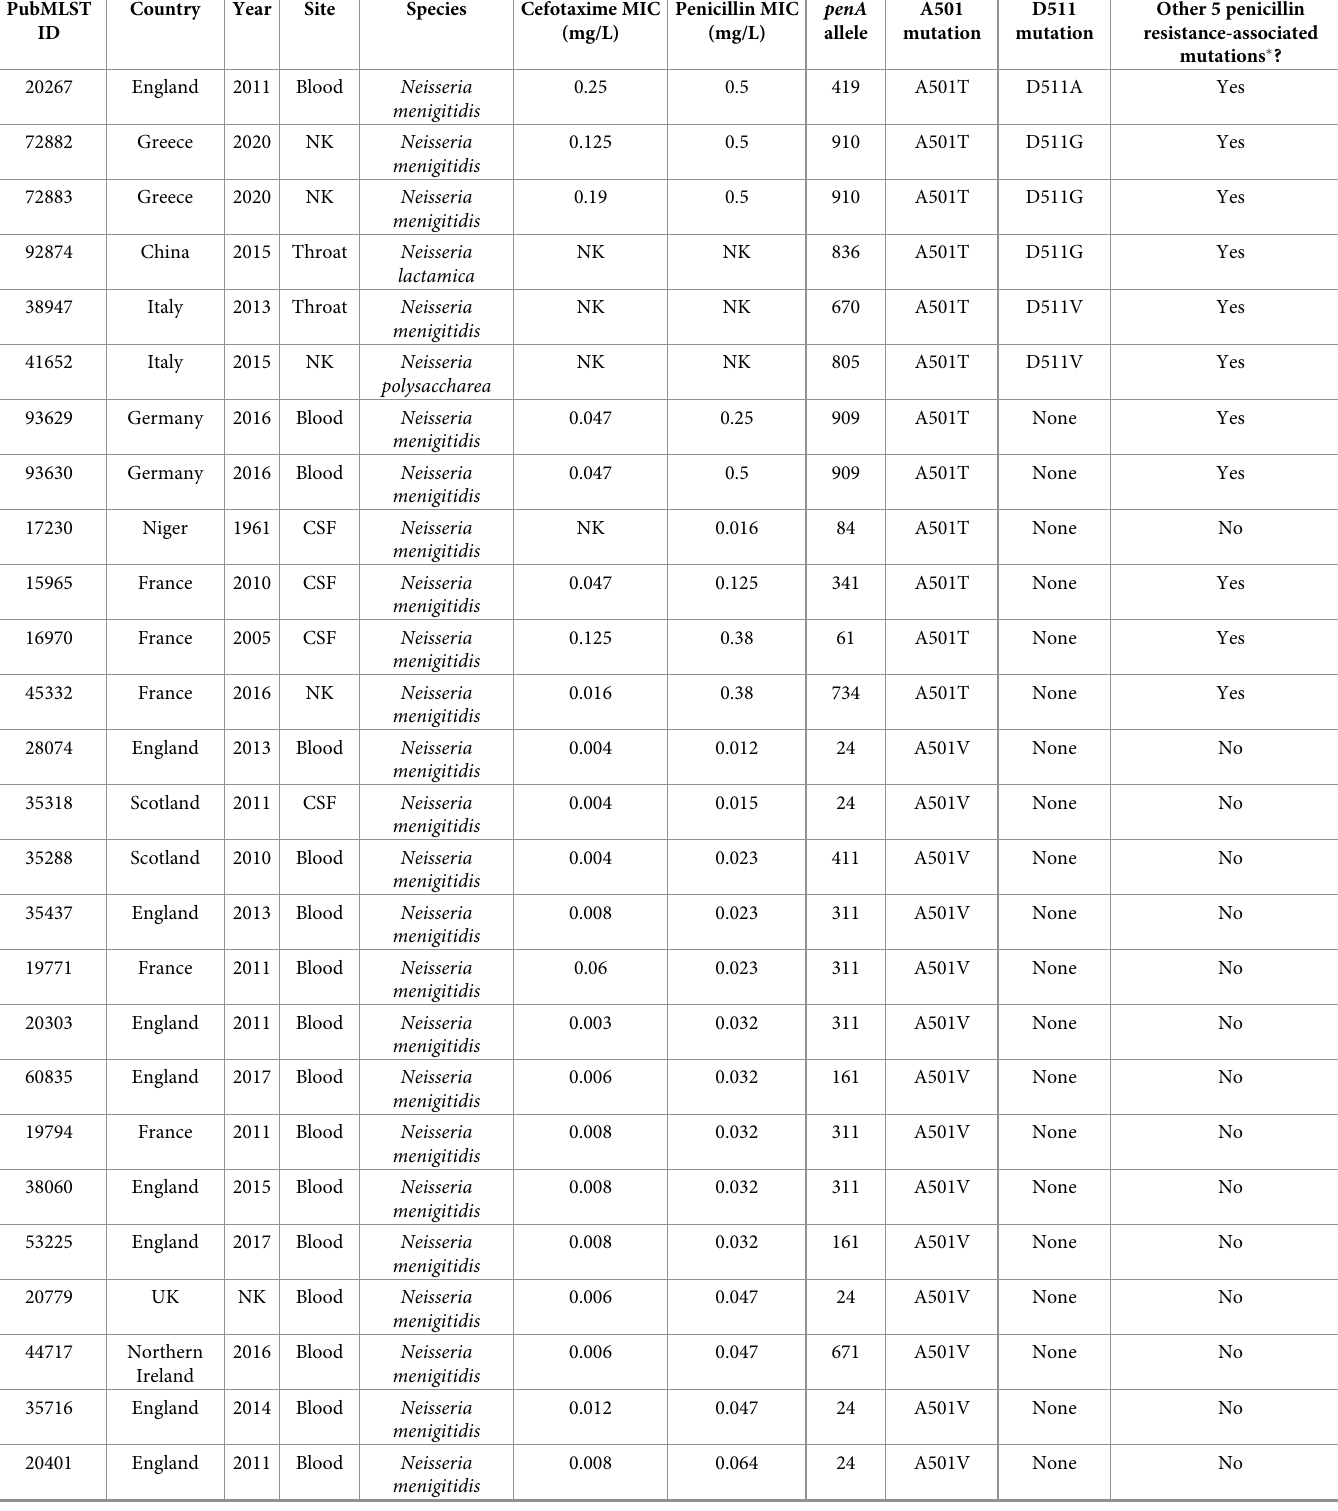
Table 3. Isolates with penA alleles harbouring AASs at positions 501 and 511 on PubMLST. PubMLST